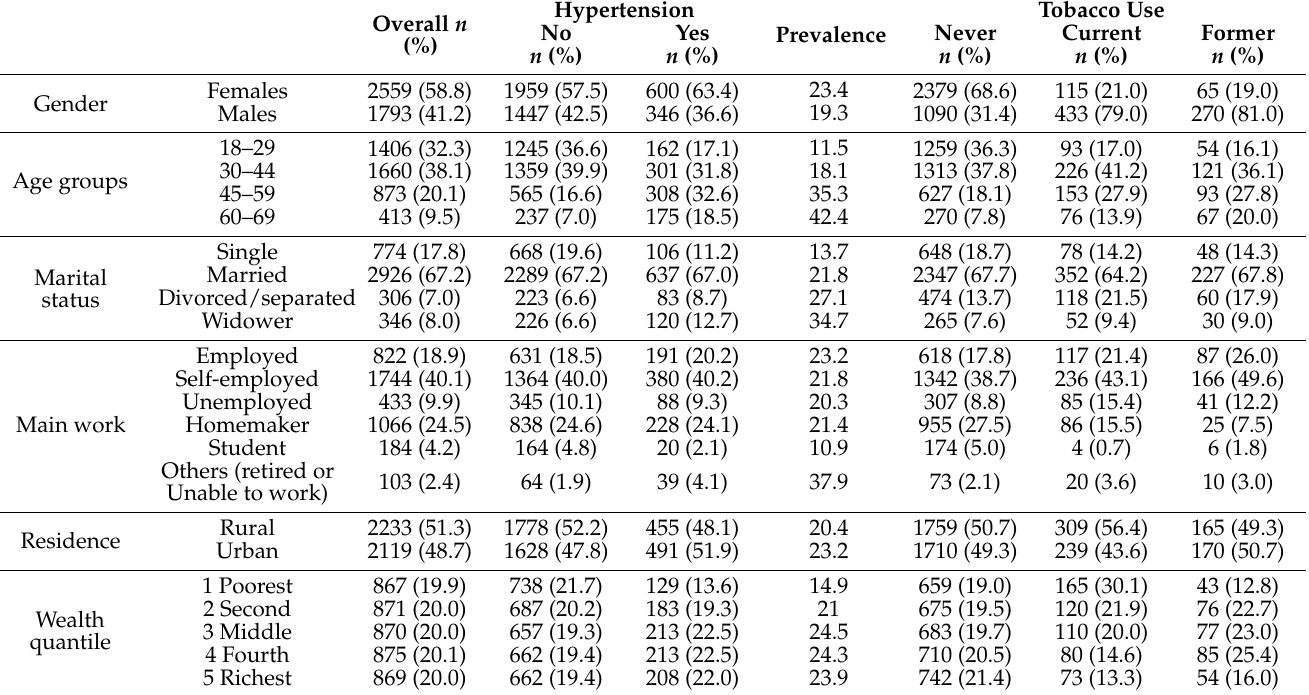
Table 1. Demographic characteristics of participants’ hypertension status and tobacco use